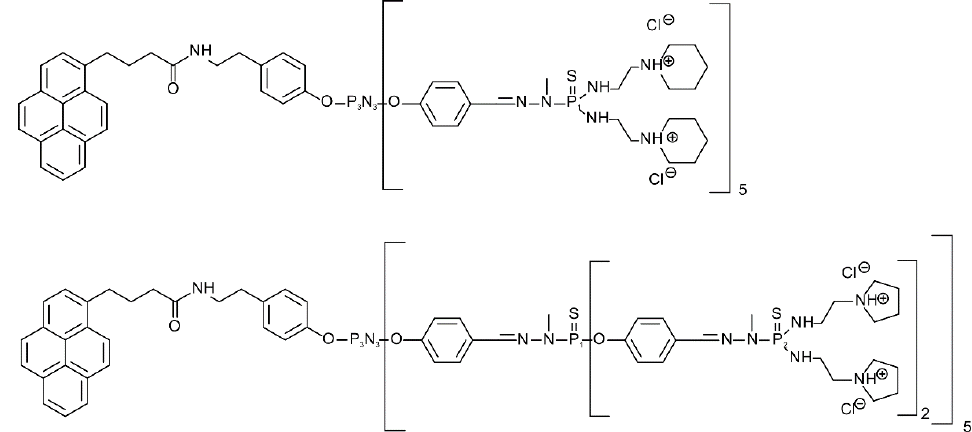
Figure 1. Structure of first-generation dendron, D1 ( top ); second-generation dendron, D2 ( bottom